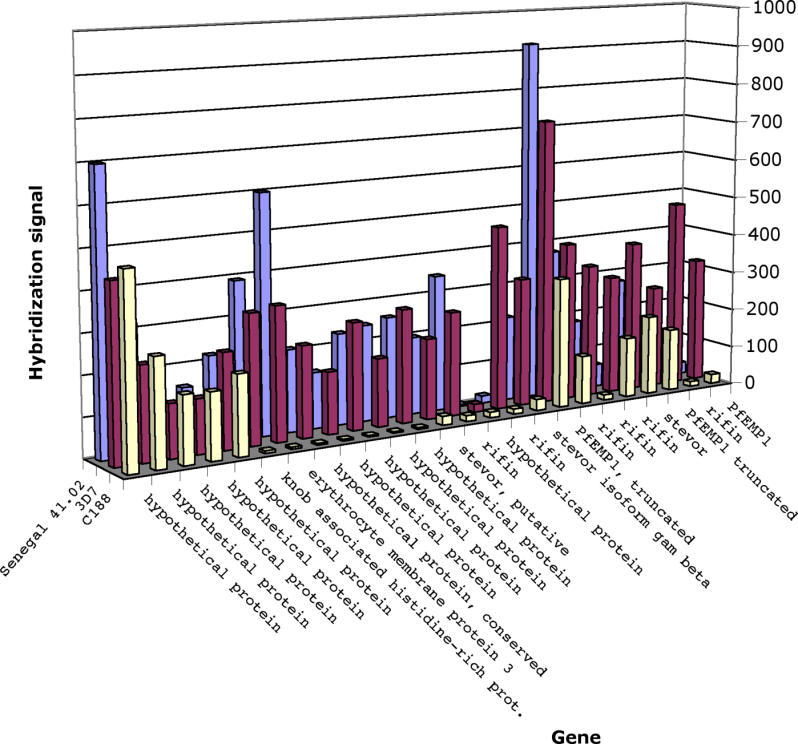
Example of a Deleted RegionHybridization levels were calculated with the MOID algorithm as previously described [59]. The figure shows the signal for 26 genes beginning with PFB0010w and ending with PFB0120w for three strains (41.02, 3D7, and C188). The background level (zero) was determined by analyzing the signal of non-P. falciparum genes on the array. Data for all genes and all strains are available from Table S12.